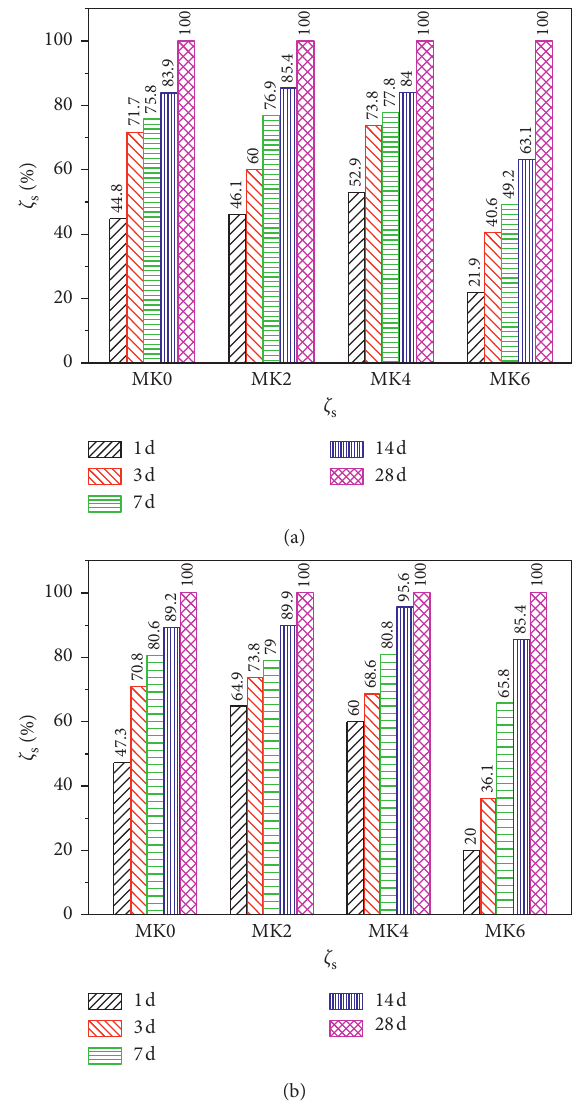
Figure 4: Test results of ζ s and ζ e of MK-cemented silty clay at different curing times. (a) ζ s and (b) ζ e